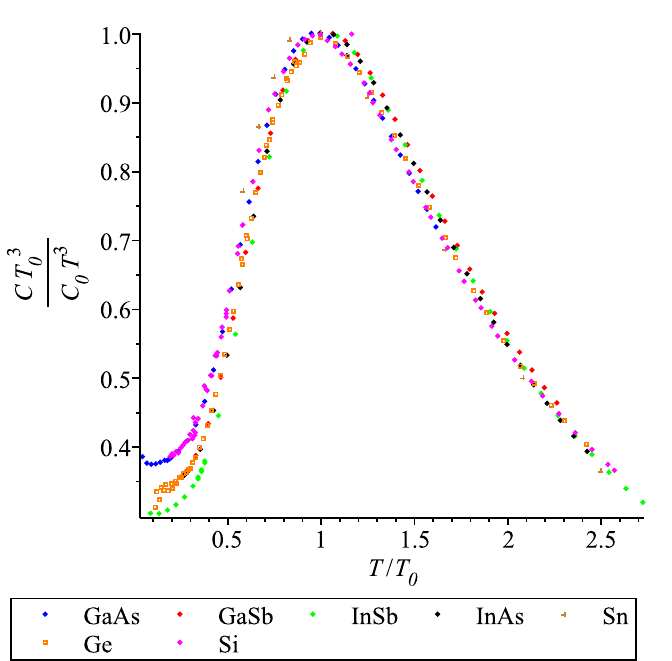
3 graphs for the diamond and zincblend lattice